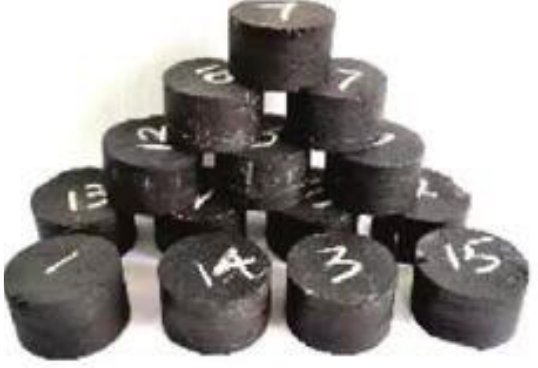
Figure 5. Raw coal test pieces.